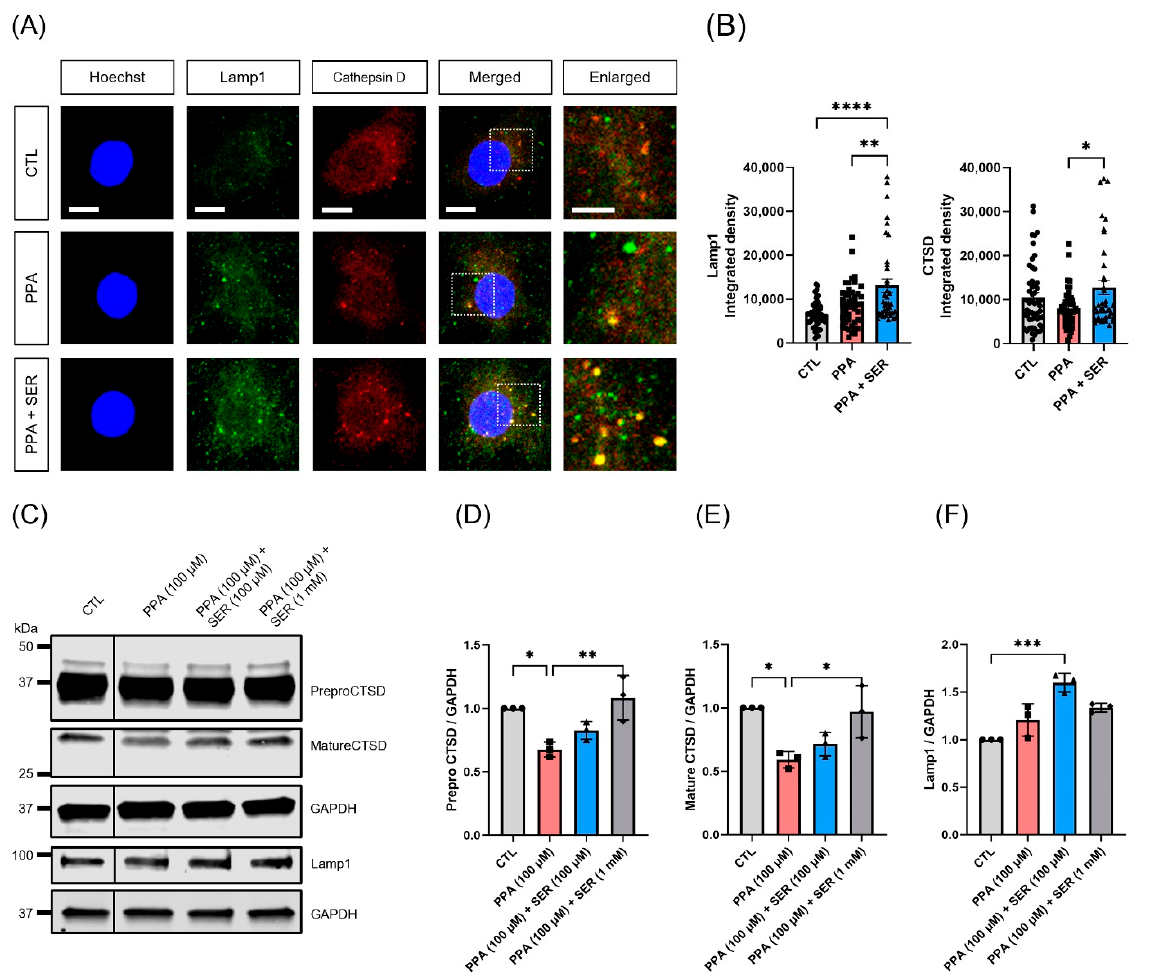
Figure 6. L-serine (SER) increased lysosomal activity in hippocampal neurons. ( A ) Representative lamp1 and CTSD immunocytochemistry images of rat hippocampal neurons. Cultured neurons were treated at DIV 18 with 100 µ M PPA or 100 µ M PPA and 100 µ M L-serine for 48 h, and immunolabelled for lamp1 or CTSD. Scale bar, 10 µ m; 5 µ m (right, the magnified images). ( B ) Quantification of the integrated density of lamp1 or CTSD in hippocampal neurons ( n = 40). ( C ) Representatives immunoblot of lamp1 and CTSD. ( D , E ) Analysis of CTSD protein expression by quantification of CTSD levels normalized to GAPDH. ( F ) Analysis of Lamp1 protein expression by quantification of lamp1 levels normalized to GAPDH. Data obtained from independent experiments ( n = 3 replicates) are presented as the mean ± SEM. * p < 0.05, ** p < 0.01, *** p < 0.001, **** p < 0.0001 by one-way ANOVA, Tukey’s multiple-comparison test.